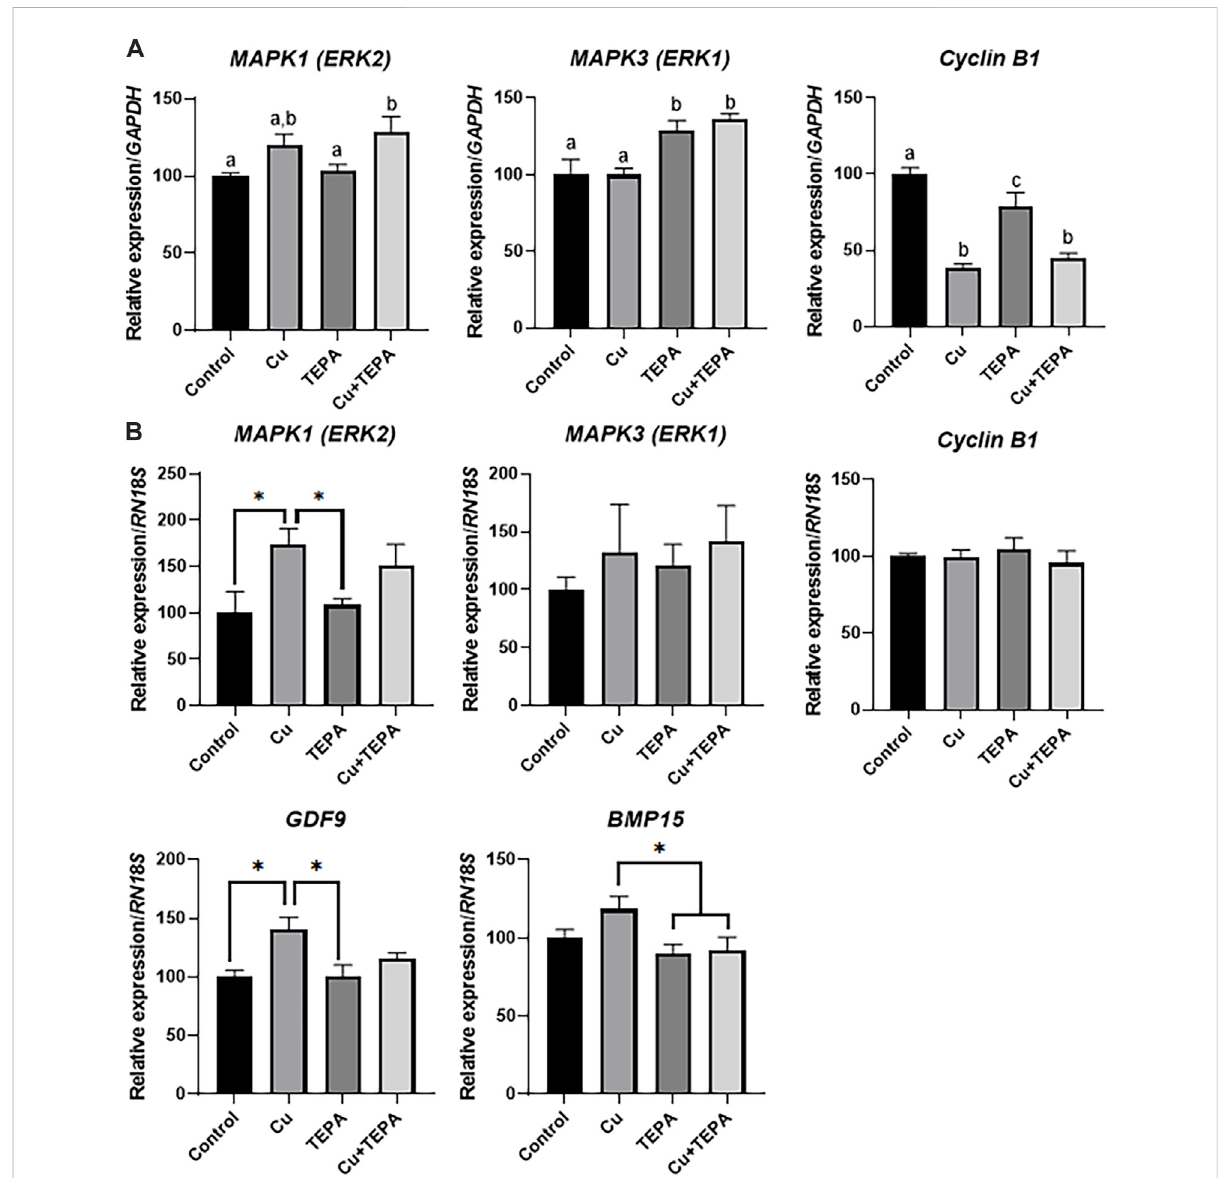
FIGURE 5 Effect of Cu chelation during in vitro maturation (IVM) on the relative mRNA expression levels of folliculogenesis-related genes. (A) The relative mRNAexpressionlevelsof MAPK1 , MAPK3 ,and CyclinB1 ,normalizedtotheexpressionlevelsof GAPDH ,werecomparedamongthecumuluscellsof each group. (B) The relative mRNA expression levels of MAPK1 , MAPK3 , Cyclin B1 , GDF9 , and BMP15 , normalized to the expression levels of RN18S , werecomparedamongoocytesineachgroup.Forallgraphs,thevaluesrepresentthemean±SEM.Theexperimentwasreplicatedthreetimes. The values (a – c) with different superscripts within the same column are signi fi cantly different ( p < 0.05 ). Asterisks indicate statistical signi fi cance (* p <